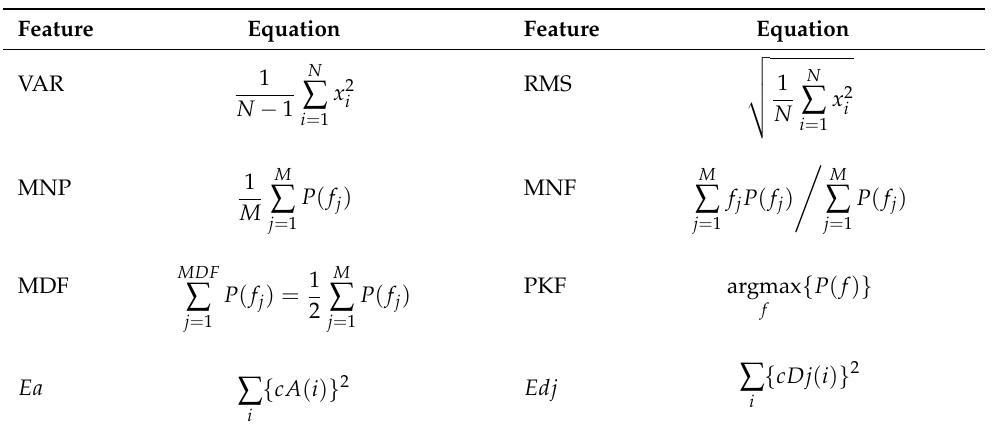
Table 2. Mathematical formulations of features.